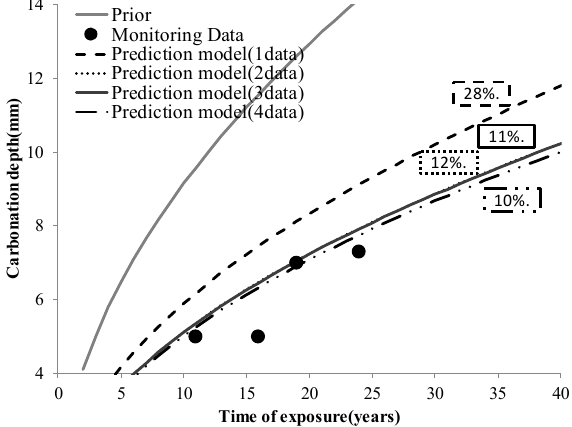
Figure 5. Updated prediction model considering di ff erent numbers of on-site data of the Gajwa IC viaduct.